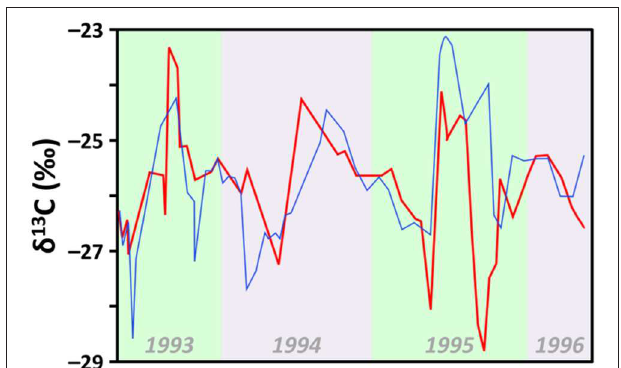
FIGURE 6 | Seasonal fluctuation of organic matter δ 13 C from two locations (red and blue lines) collected biweekly during a 3 year period in Lake Ontario, Canada. Seasonal fluctuations reflect annual shifts in productivity that influence δ 13 C by: (1) drawing down CO 2 , which (2) promotes use of HCO − 3 during C fixation. Data from Hodell and Schelske